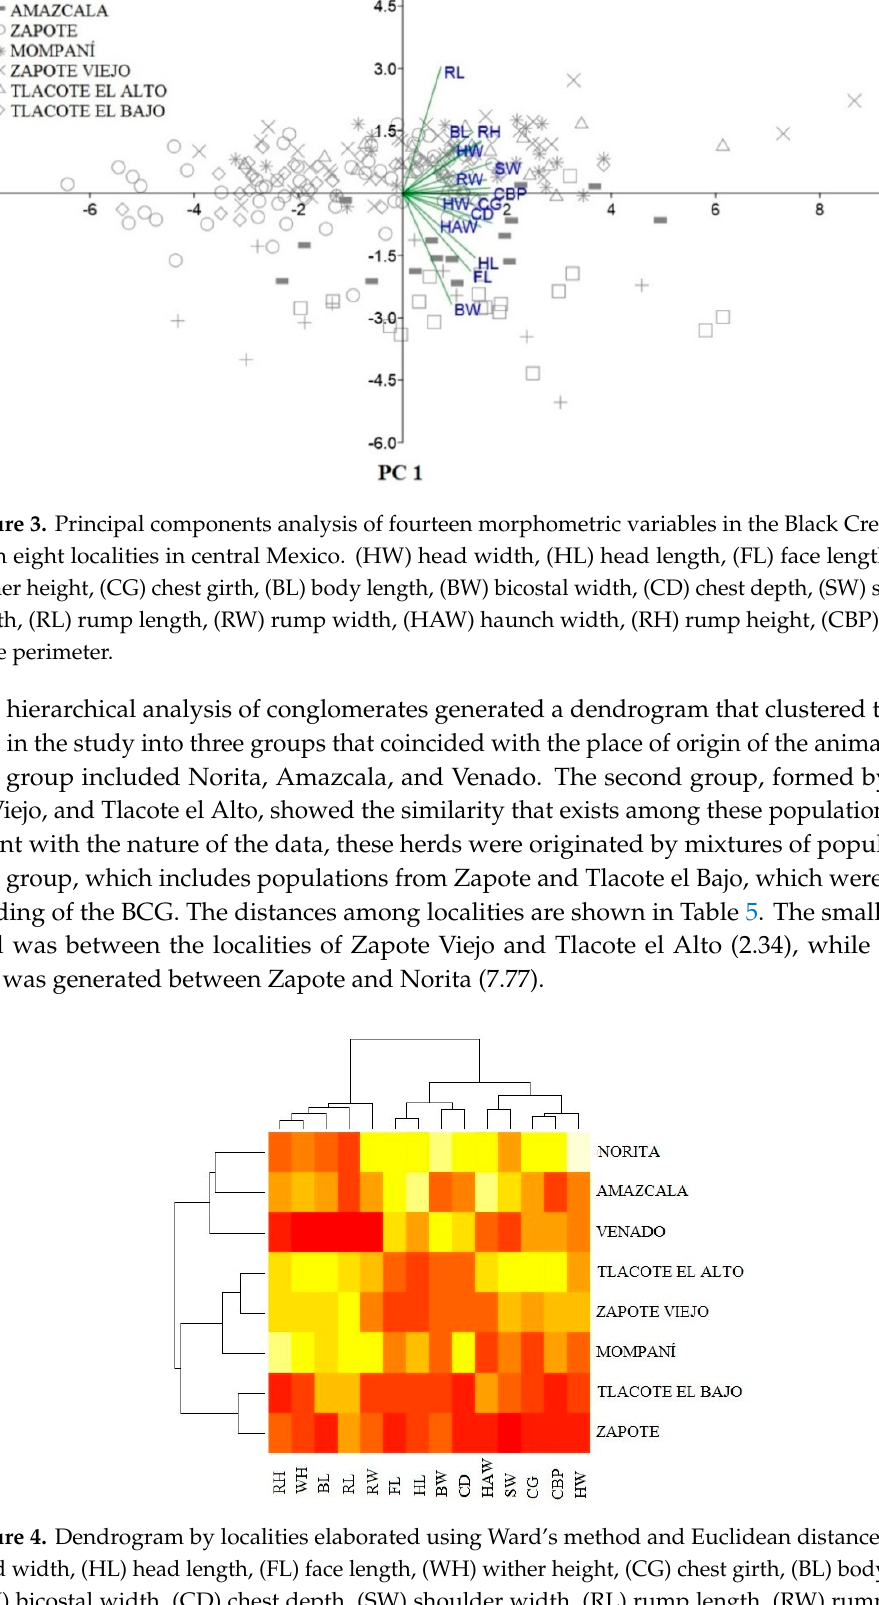
Figure 4. Dendrogram by localities elaborated using Ward’s method and Euclidean distances. (HW) head width, (HL) head length, (FL) face length, (WH) wither height, (CG) chest girth, (BL) body length, (BW) bicostal width, (CD) chest depth, (SW) shoulder width, (RL) rump length, (RW) rump width, (HAW) haunch width, (RH) rump height, (CBP) cannon bone perimeter.